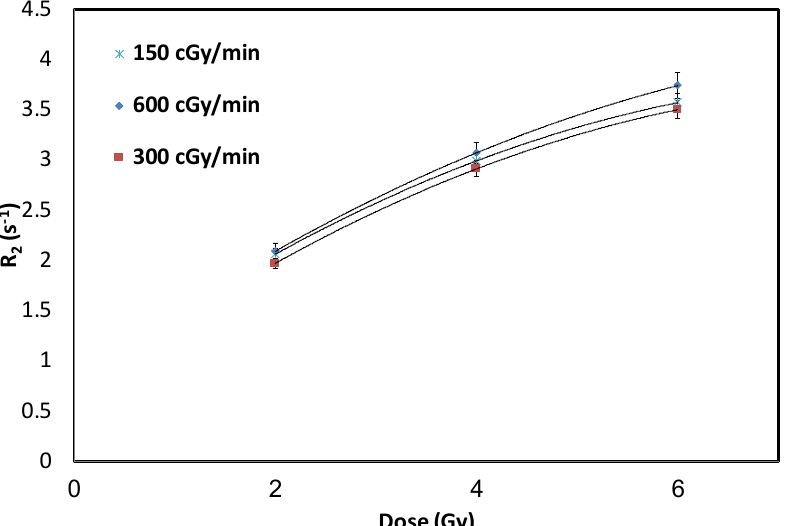
Figure 4. R 2 of gel with 500 mM CaCl 2 for various dose-rates under 10 MV radiation energy. Error bars are the 2 σ of R 2 values.